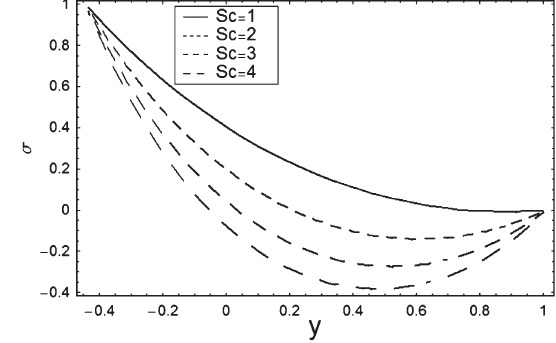
Fig. 14. Effect of the Froud number Fr on the variation of longitudinal velocity u plotted for a = 0 . 3, b = 0 . 5, d = 0 . 9, Re = 0 . 7, φ = π/ 4, (cid:15) = 0 . 15, α = π/ 6, θ = 1 . 5, x = − π/ 3, β = 0 . 02 and dp (2) /dx = 1.